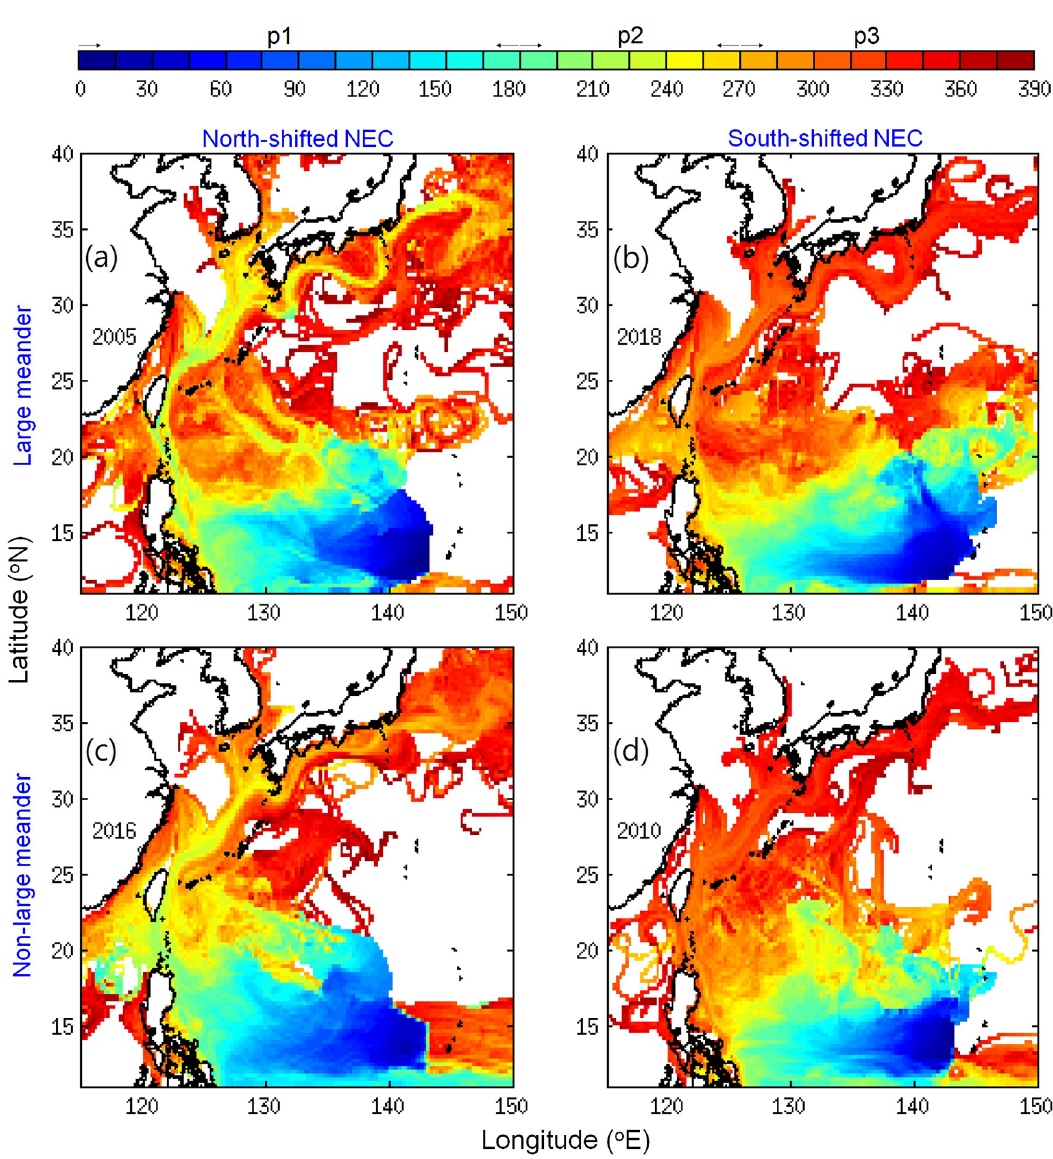
Fig 6. The averaged time taken (days) from the spawning area to each particular grid location within the simulation region. Day 0 to 180 corresponds to the early migration period (p1), day 180 to 270 to the early recruitment period (p2), and after day 270 is the late recruitment period